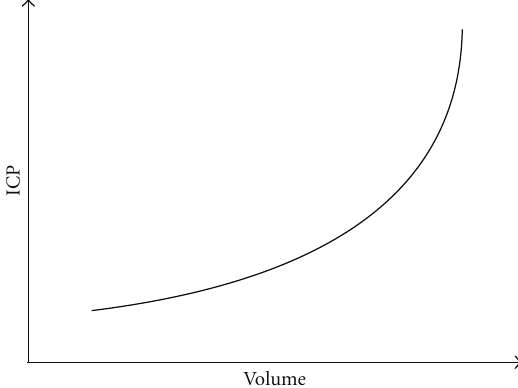
Figure 1: The relationship between intracranial pressure and volume.